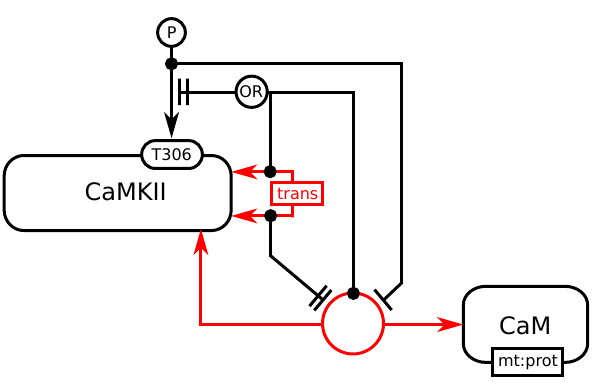
Figure 2.17: Examples of a binary interaction between CaMKII and calmodulin where the interaction is represented by a circle. Interaction between adjacent monomers of CaMKII (trans-interaction) preclude the binding of calmodulin, as represented by an absolute inhibi- tion ending on the circle. The phosphorylation of threonine 306 also inhibits the interaction. The realisation of the interaction, represented by an outcome located on the circle, itself in- hibits the phosphorylation of threonine 306.